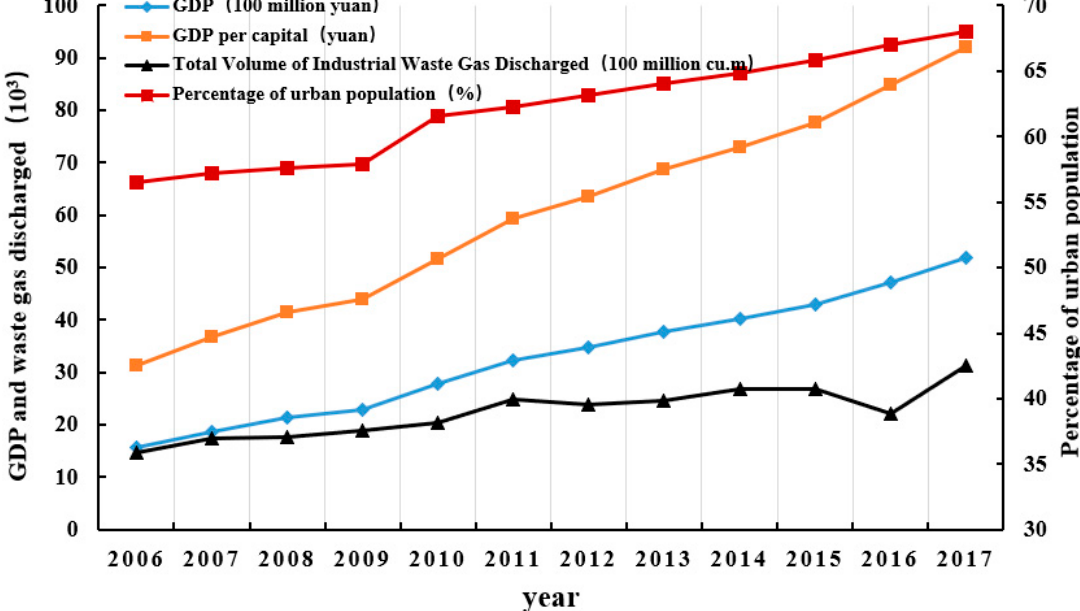
Figure 1. Indicators of economy, urbanization, and waste gas discharged in the whole of Zhejiang Province in 2006–2017. (Data source: Zhejiang Statistical Yearbook (2007–2018)